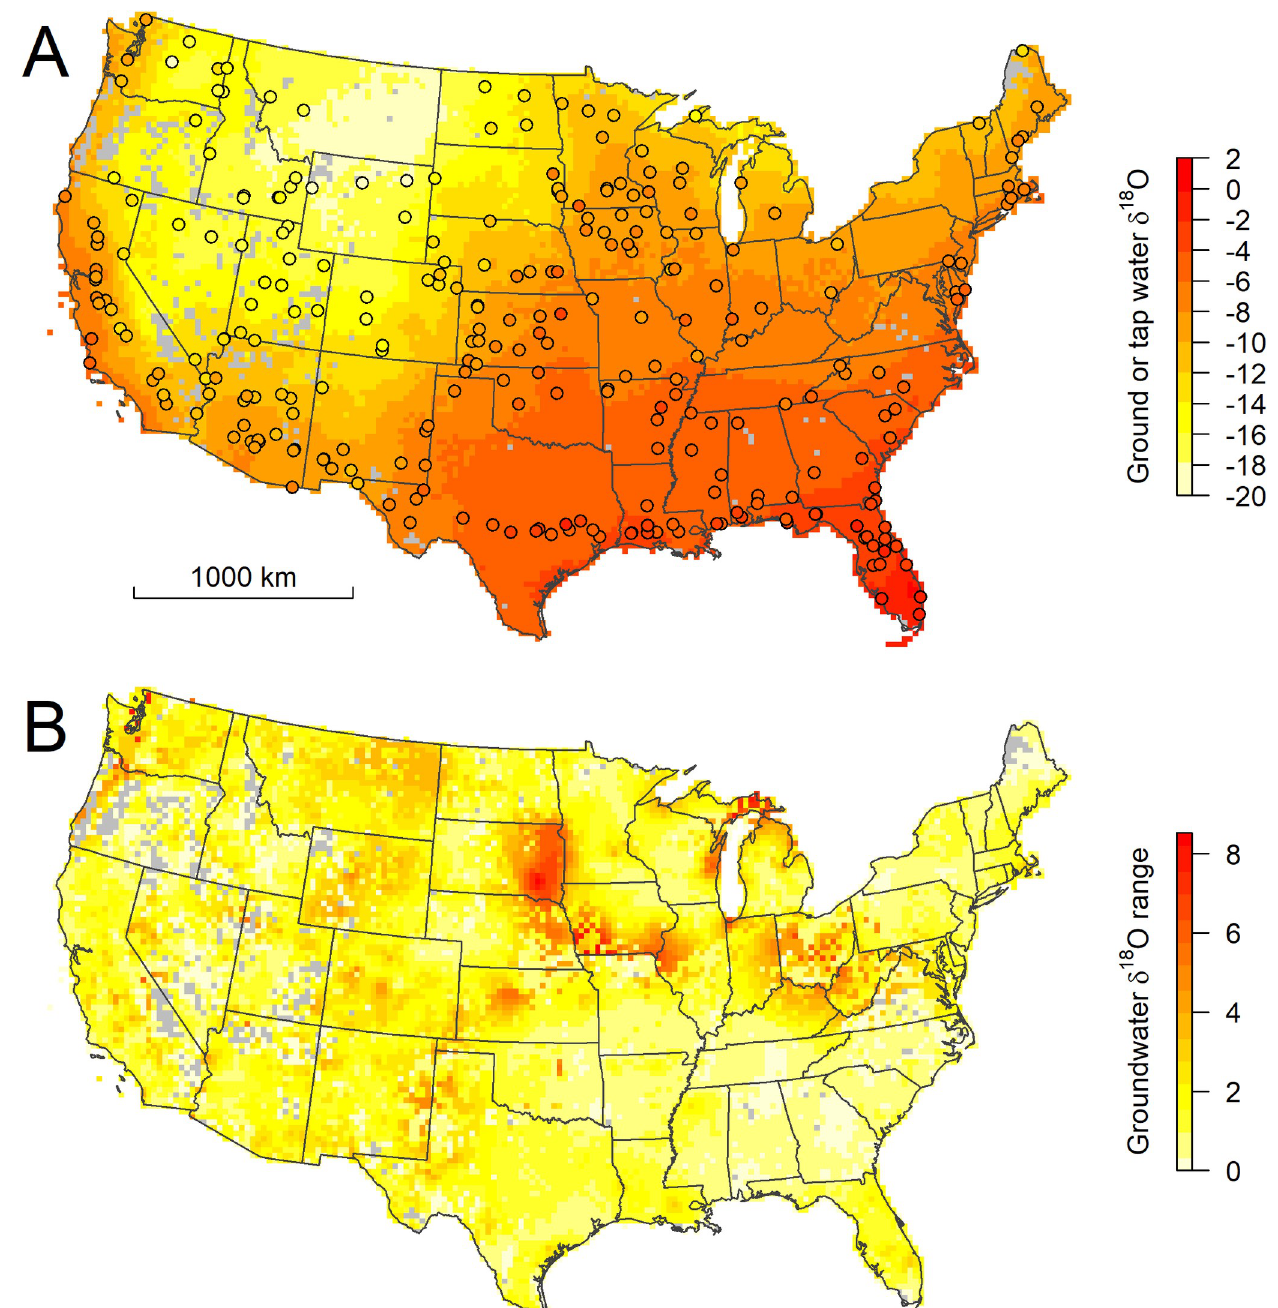
Fig 6. 2-d summary statistics (A: Mean, B: Standard deviation) for 3-d groundwater isoscape. Points in panel A show measured tap water δ values for validation sites. Gray cells contain no wells completed at any depth interval.